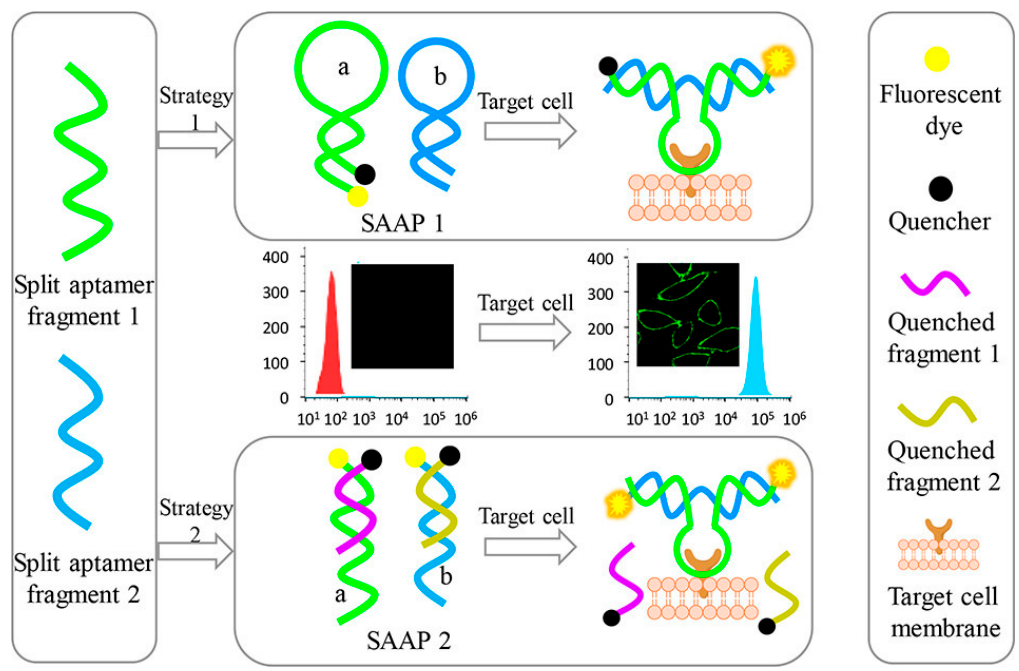
Figure 22. Schematic representation of two different self-assembly and activation strategies for cancer cell detection. Figure reproduced with permission from reference [234]. Copyright © 2017 American Chemical Society.